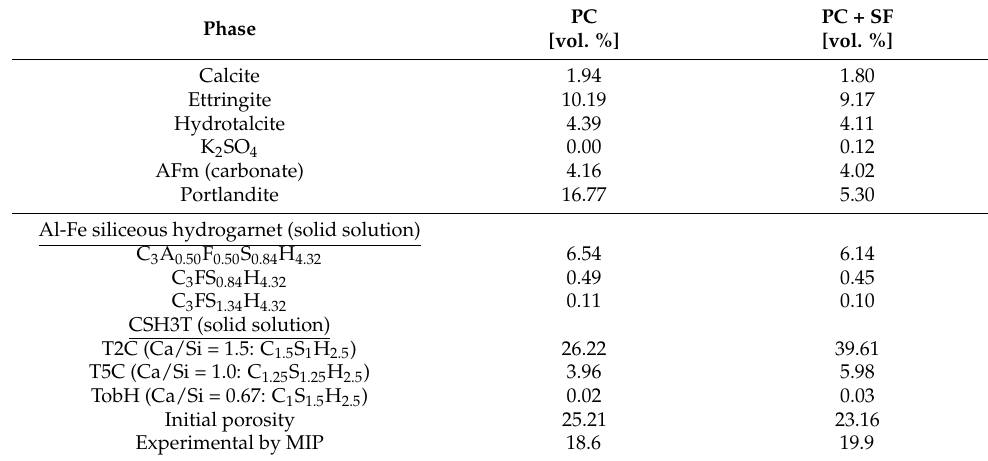
Table 3. Composition of the hydrated cement paste from Model 1 (including initial porosity compared to the experimental determined by